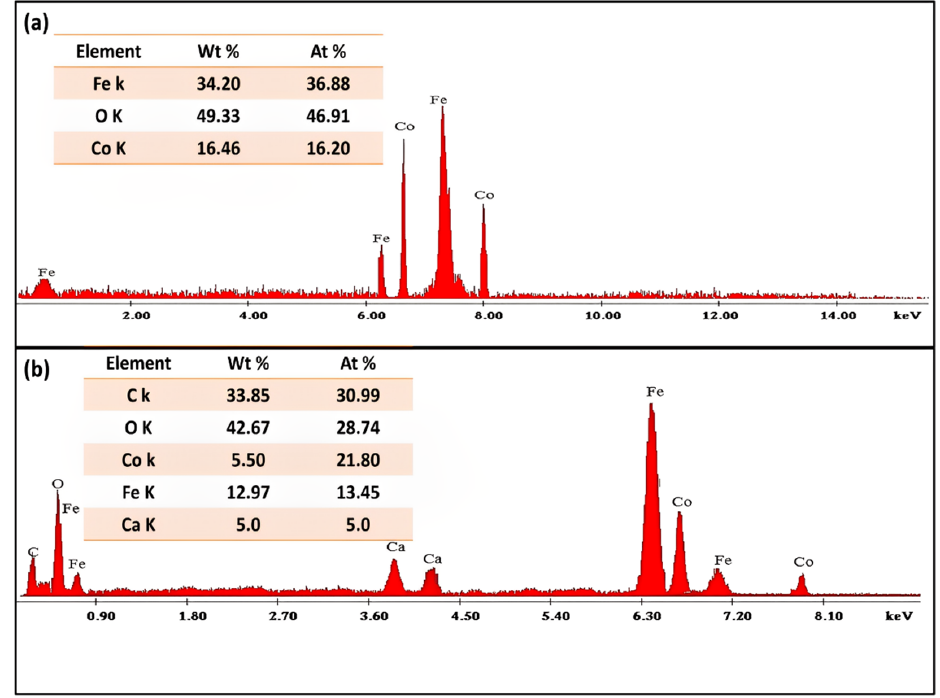
Figure 5. The elemental composition of ( a ) green synthesized CoFe 2 O 4 nanoparticles and ( b ) CoFe 2 O 4 /Ca ‐ Alg nanocomposite, respectively. Inset: the corresponding table of elements